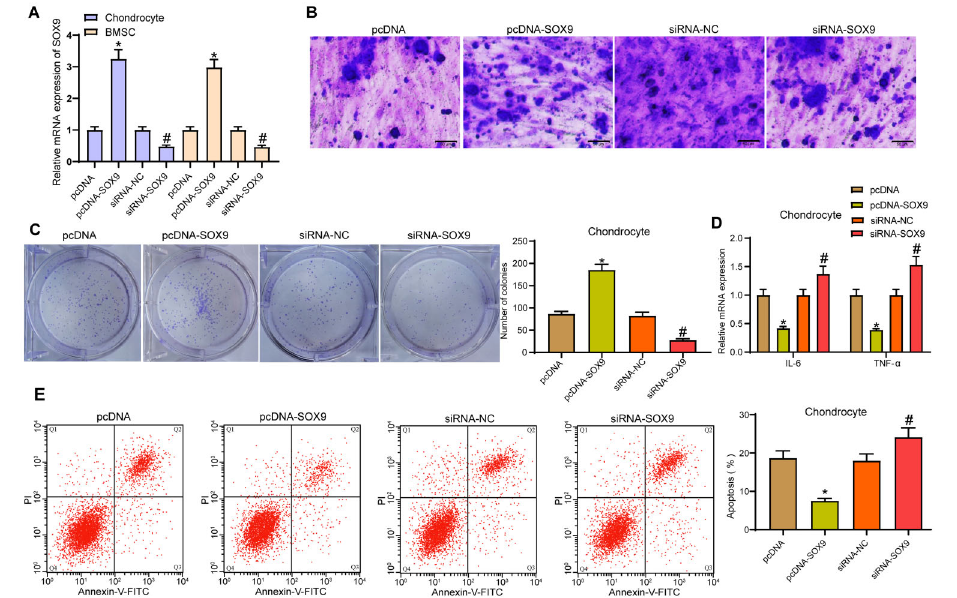
Figure 4. Overexpression of SOX9 promotes chondrogenic differentiation of bone marrow mesenchymal stem cells (BMSCs) and chondrocyte growth. A , Transfection ef fi ciency measured by RT-qPCR. B , Toluidine blue staining detected the effect of pcDNA-SOX9 and siRNA-SOX9 on the synthesis of extracellular matrix in the process of cartilage differentiation of BMSCs (scale bar, 50 m m). C , Effect of pcDNA-SOX9 and siRNA-SOX9 on the proliferation of interleukin (IL)-1 b -treated chondrocytes measured by colony formation assay. D , RT-qPCR measured the effects of pcDNA-SOX9 and siRNA-SOX9 on the expression of IL-6 and TNF- a . E , Effect of pcDNA-SOX9 and siRNA-SOX9 on apoptosis of IL-1 b -treated chondrocytes measured by fl ow cytometry. Data in panels A , C , and E were processed using one-way ANOVA, and data in panel D were analyzed using two-way ANOVA. *P o 0.05 compared to cells transfected with pcDNA; # P o 0.05 compared to cells transfected with siRNA-NC. Experiments were repeated 3 times